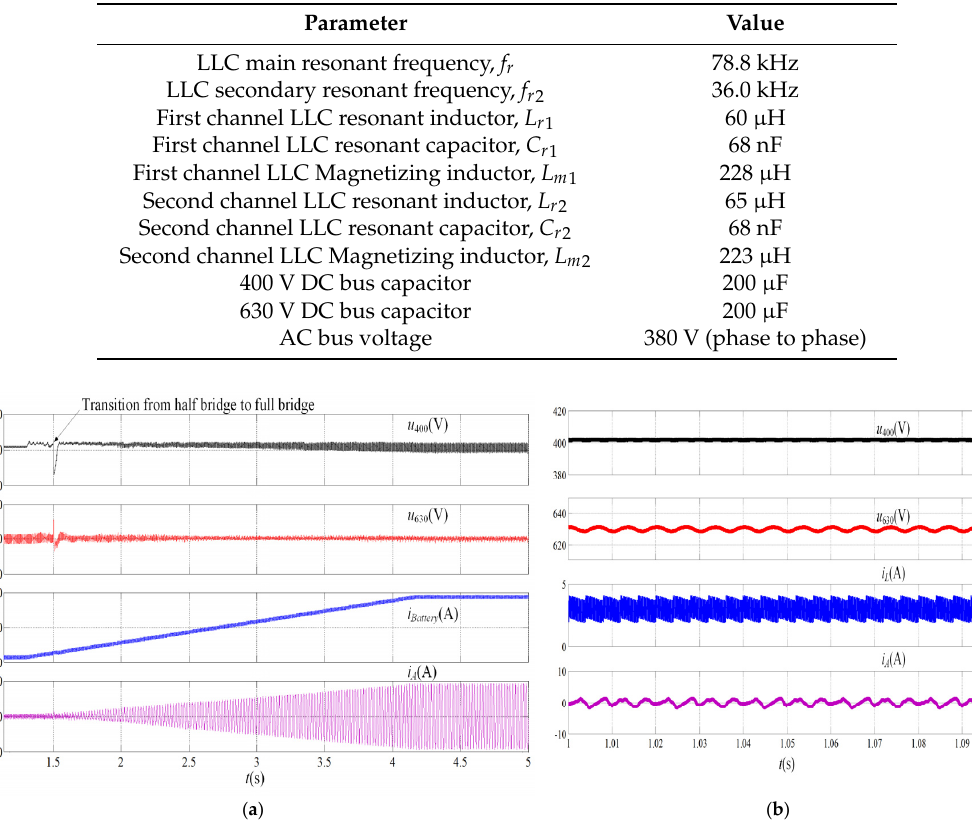
Figure 11. Simulation results in on-line mode: ( a ) transition waveforms; and ( b ) steady state waveforms with light load.